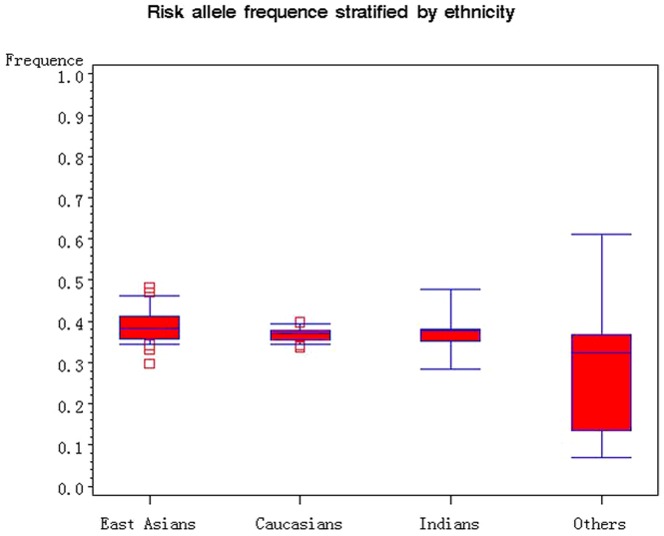
Frequencies of the 23K allele of KCNJ11 rs5219 polymorphism among controls stratified by ethnicity.The “□” represent outlier.